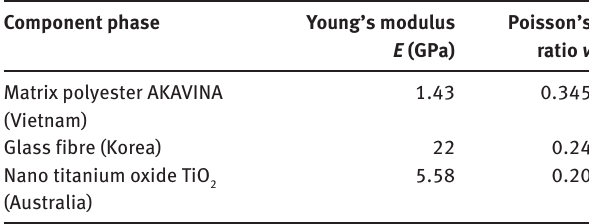
Table 1: Properties of the component phases for the three-phase polymer composite.